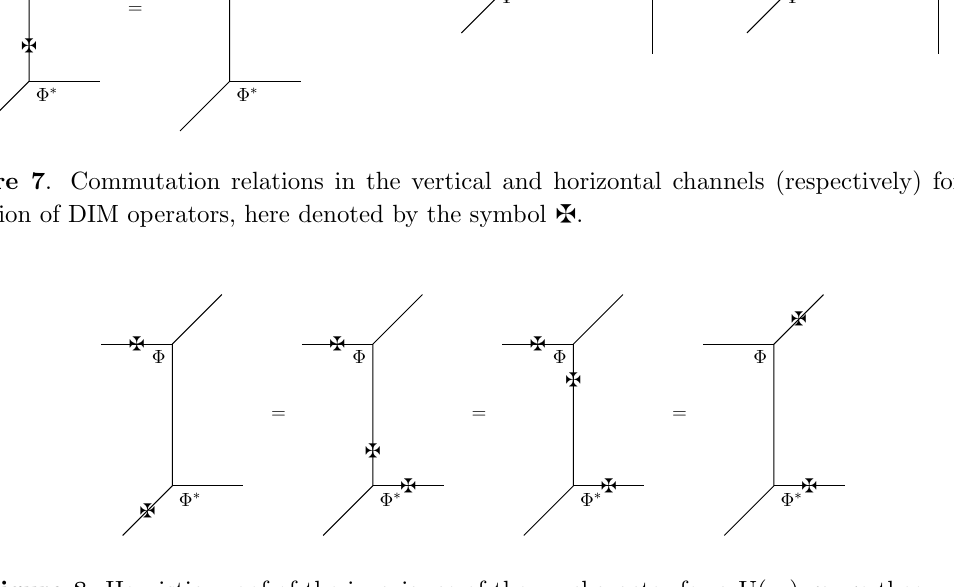
Figure 8 . Heuristic proof of the invariance of the qq-character for a U( m ) gauge